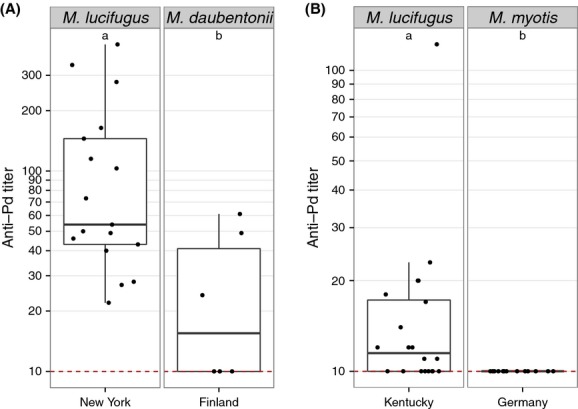
Comparison of anti-Pd antibody titers in free-ranging bat species in North America and Europe. (A) Anti-Pd titers were greater in little brown myotis (Myotis lucifugus) in New York, USA, than in Daubenton's myotis (M. daubentonii) in Finland during spring. (B) Anti-Pd titers were greater in little brown myotis hibernating in Kentucky, USA, than in Daubenton's myotis hibernating in Germany. Data are presented as quartiles, median (black line), and whiskers that represent 1.5 times the interquartile range. Titers ≤ 10 are considered negative for Pd reactive antibodies. Titers differed significantly between species not sharing common letters within each panel (P < 0.05).